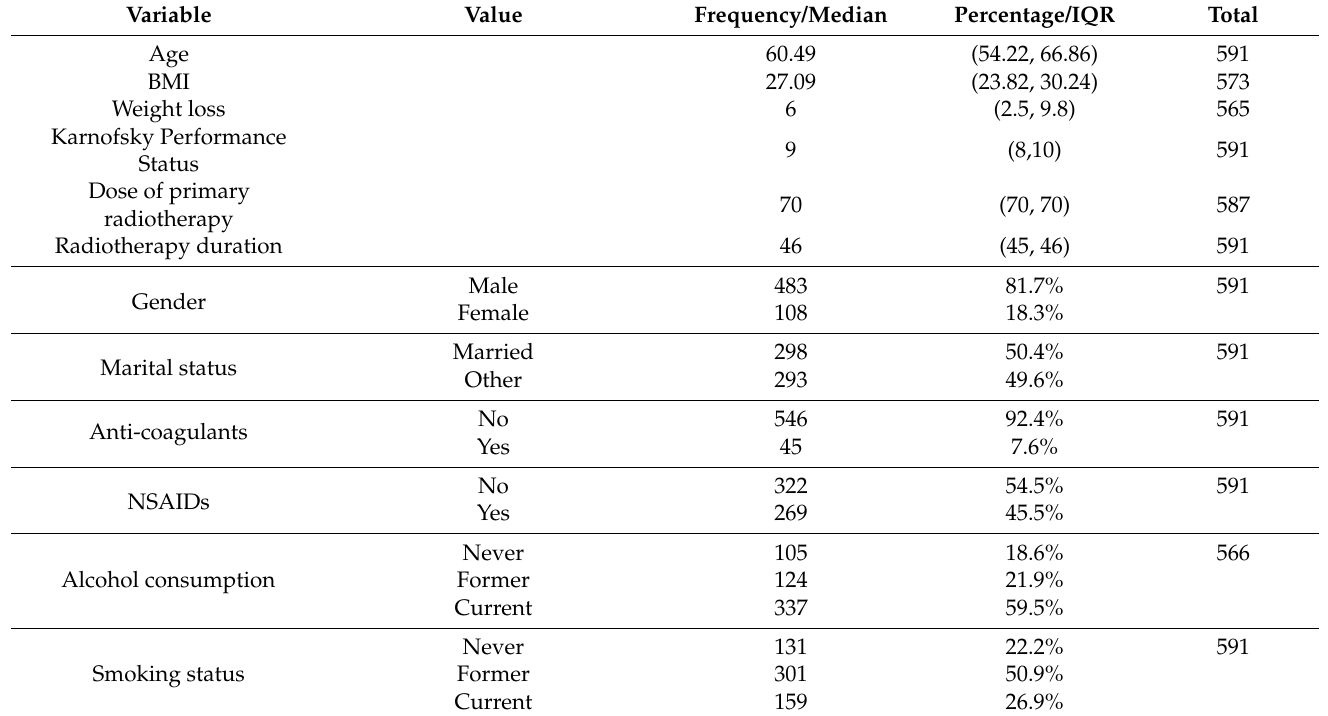
Table 1. Summary of patient